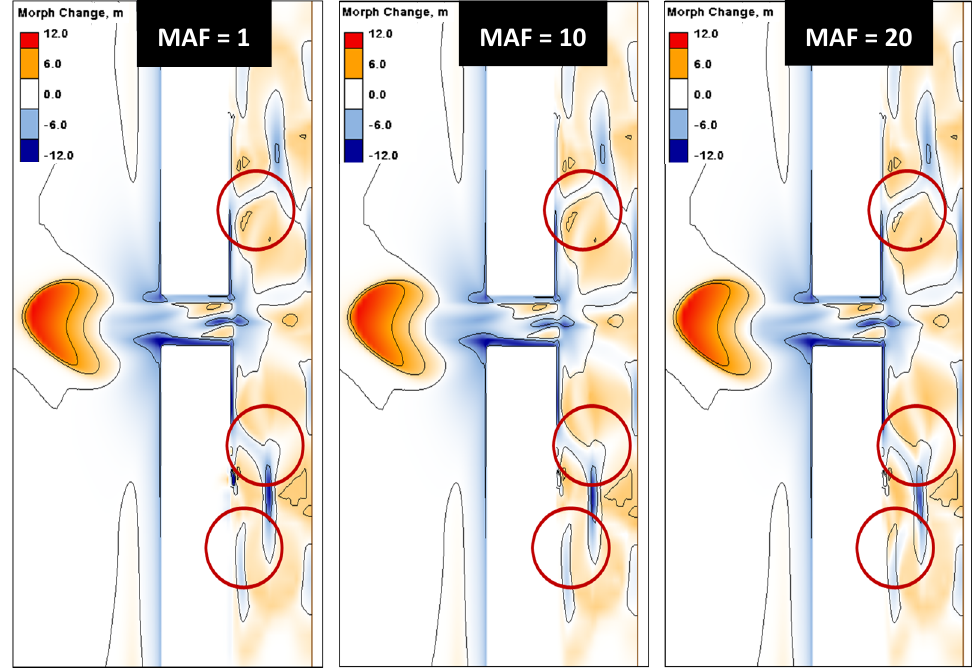
Figure 1. Comparison of morphologic change for Morphology Acceleration Factor (MAF) values of 1, 10, and 20. Blue and red colors represent morphology change over the morphology change contours (black lines) from MAF value of 1, and red ovals indicate areas of observed qualitative change.